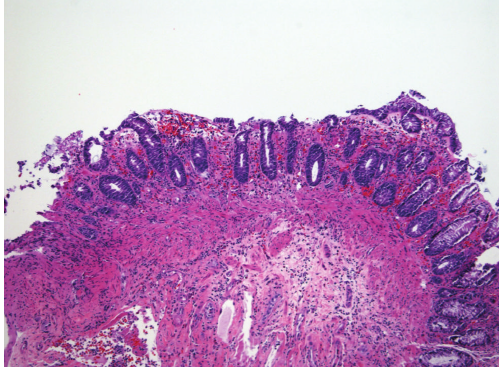
Figure 3: Colonic biopsy at medium magnification (100x, H&E stain) showing features characteristic of ischemic injury, including crypt atrophy, loss of cytoplasmic mucin, nuclear hyperchromasia, and absence or shedding of the luminal surface epithelium.